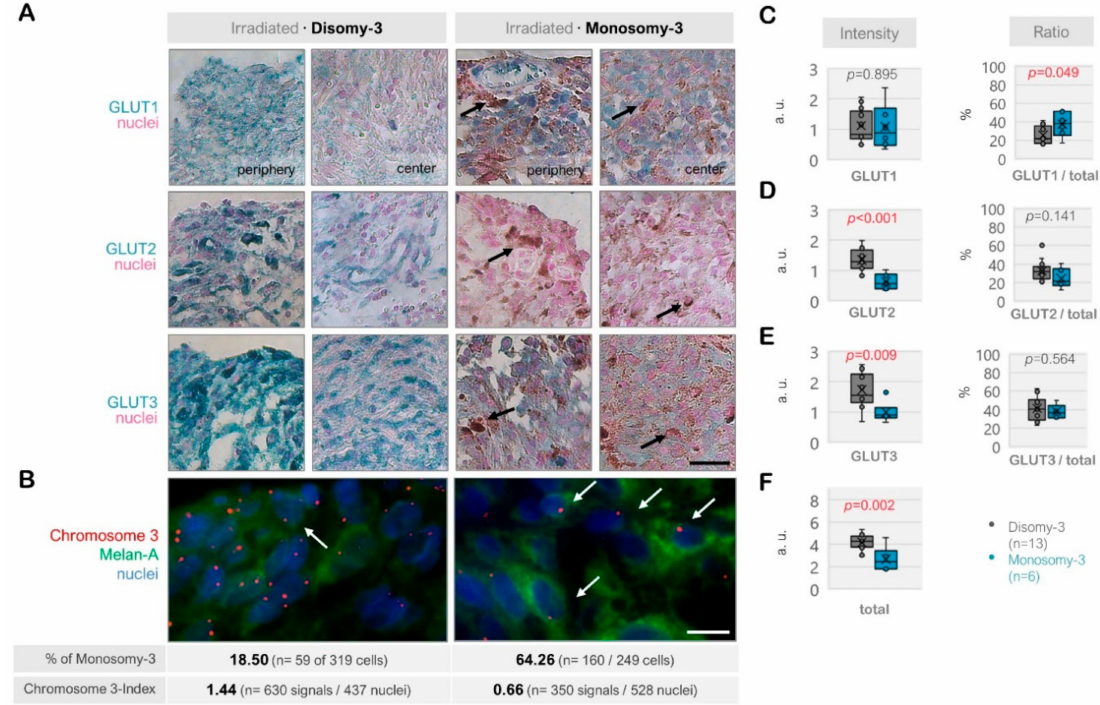
Figure 3. Expression of the glucose transporters GLUT1, GLUT2, and GLUT3 in the irradiated uveal melanoma (UM) samples. ( A ) Representative images from the immunohistochemistry for GLUT1-3. The disomy-3 tumor originates from a male patient (60 years), who remained metastasis-free during the follow-up, whereas the monosomy-3 tumor was obtained from another male patient (52 years), who has developed liver metastases. Irradiation was performed two months prior to the acquisition of both tumors. Images were collected at an original magnification of 200 × . Arrows indicate varying degrees of pigmentation. Scale bar = 25 µ m. ( B ) Immuno-Fluorescent in situ hybridization (Immuno-FISH) analysis, demonstrating the copy number of chromosome-3 (red) in the UM cells that were expressing the melanoma marker Melan-A (green). The nuclei were counterstained in blue with DAPI. Arrows indicate several cells with monosomy-3. The percentage (%) of monosomy-3 cells and the chromosome index of these tumors were presented underneath the respective images (please see the Methods for the detailed description of the calculation of these parameters, n : number). Scale bar = 10 µ m. Quantification of the intensity and ratio of ( C ) GLUT1, ( D ) GLUT2, and ( E ) GLUT3 in the irradiated primary UMs with regard to the monosomy-3 status. ( F ) The sum of the GLUT1-3 intensities was presented as “total.” p -values were determined by the unpaired, two-sided t -test. The significant p -values ( < 0.05) were highlighted in red. a.u.: Arbitrary